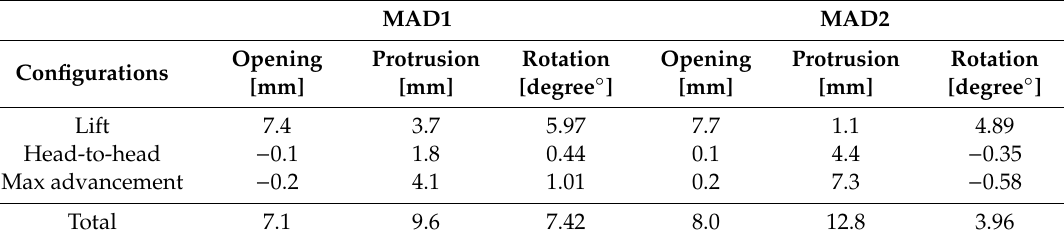
Table 3. Mandibular roto translations (vertical opening, horizontal protrusion, and rotation angle) induced by MADs.